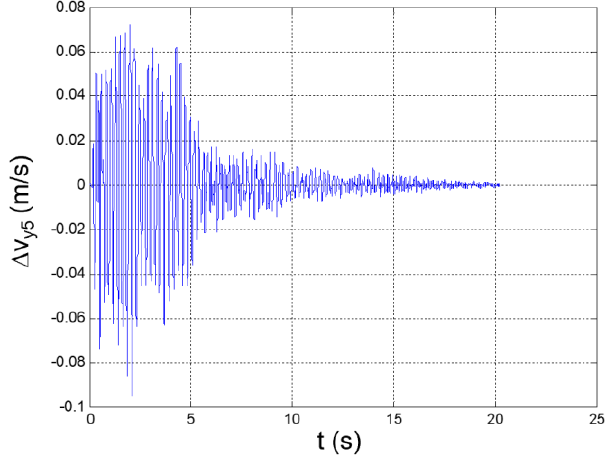
Figure 19. Seismic response, interstory speed at the 5th floor ( Δ 𝑣 y5 = 𝑣 y5 − 𝑣 y4 ).